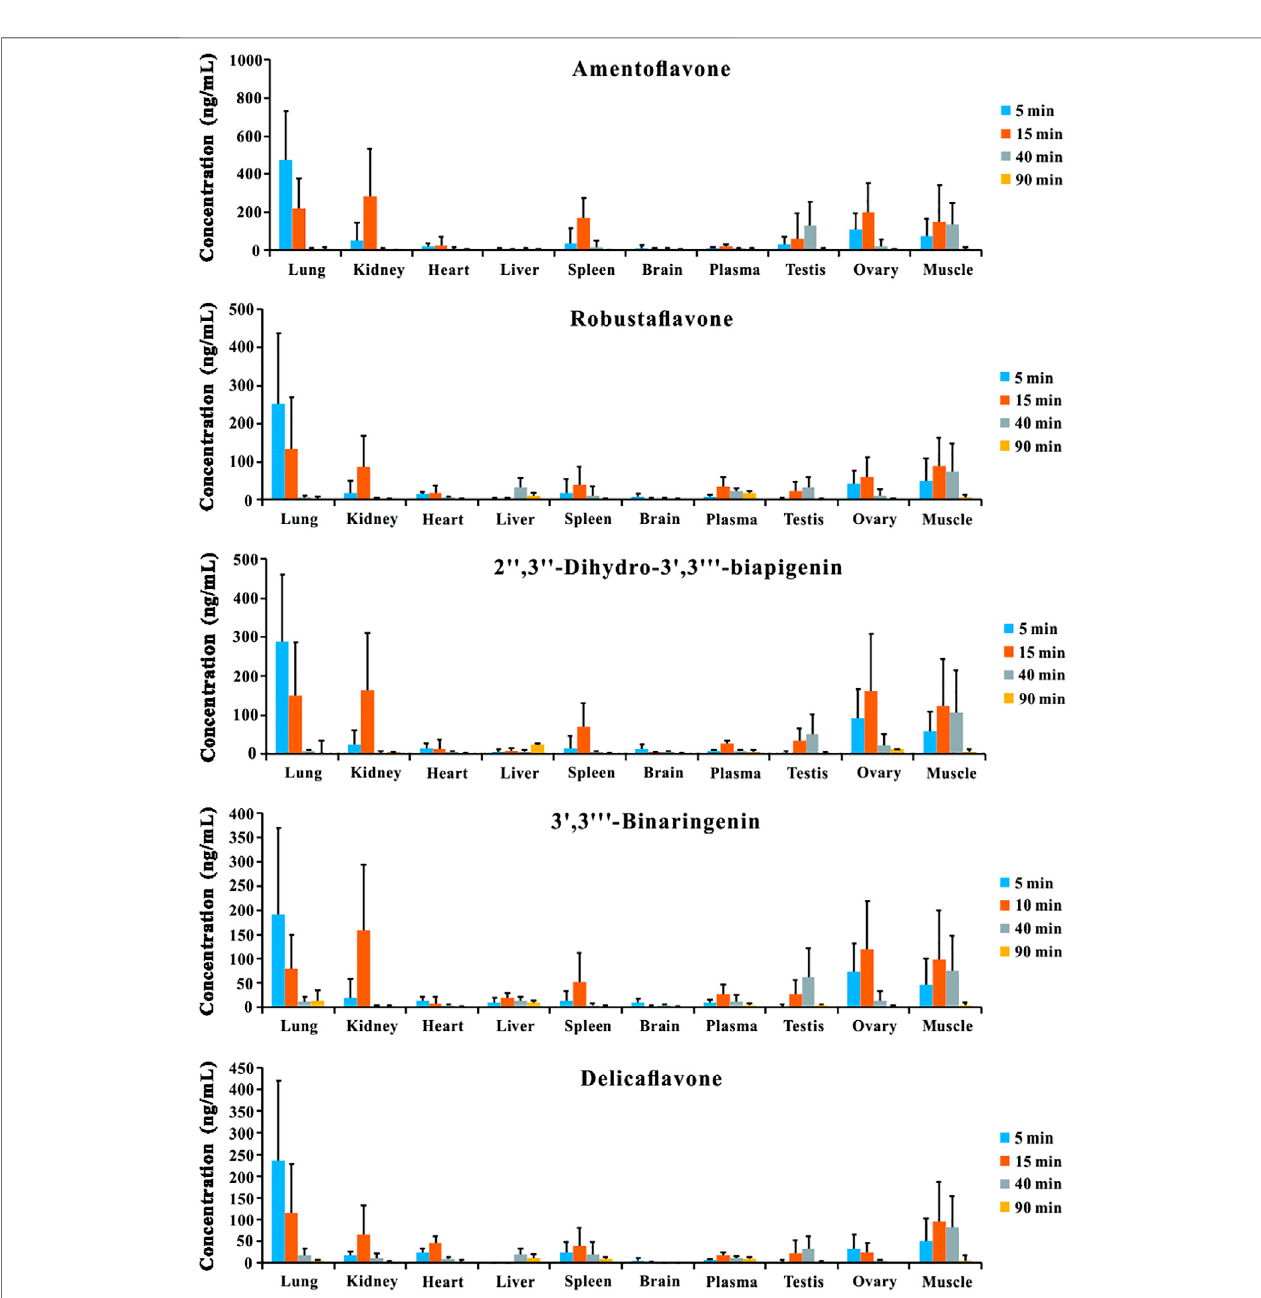
FIGURE 2 | Tissue distribution pro fi les of amento fl avone, robusta fl avone, 2 ″ ,3 ″ -dihydro-3 ′ ,3 ‴ -biapigenin, 3 ′ ,3 ‴ -binaringenin, and delica fl avone in rat after oral administration of TBESD at a dose of 600 mg/kg (Mean ± SD, n = 6).